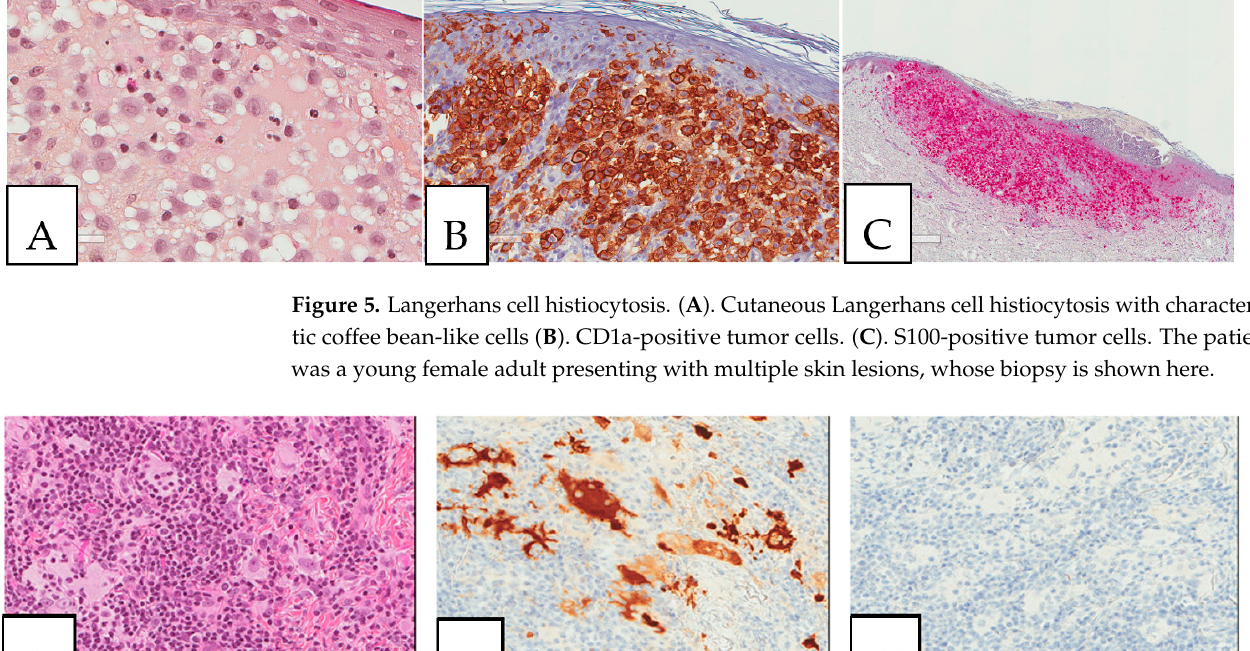
with RAS/MAPK pathway mutations, especially the BRAF V600E mutation, which pre-